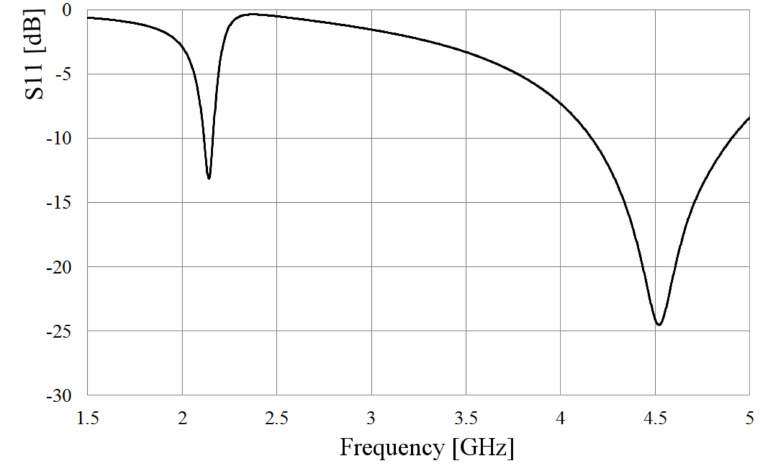
Figure 10. Simulated S11 parameter of the second loop-slot antenna.